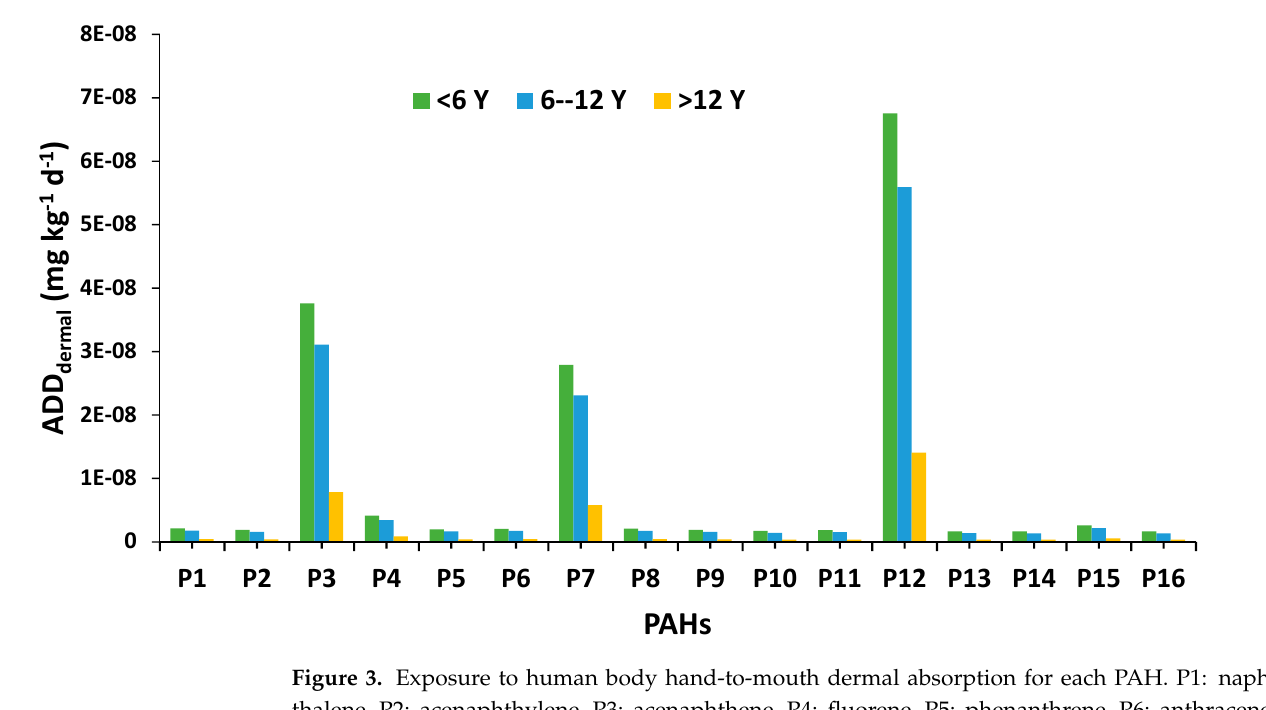
Figure 3. Exposure to human body hand-to-mouth dermal absorption for each PAH. P1: naphtha ‐ lene, P2: acenaphthylene, P3: acenaphthene, P4: fluorene, P5: phenanthrene, P6: anthracene, P7: flu ‐ oranthene, P8: pyrene, P9: benzo(b+j)fluoranthene, P10: benzo(k)fluoranthene, P11: benzo(a)pyrene,